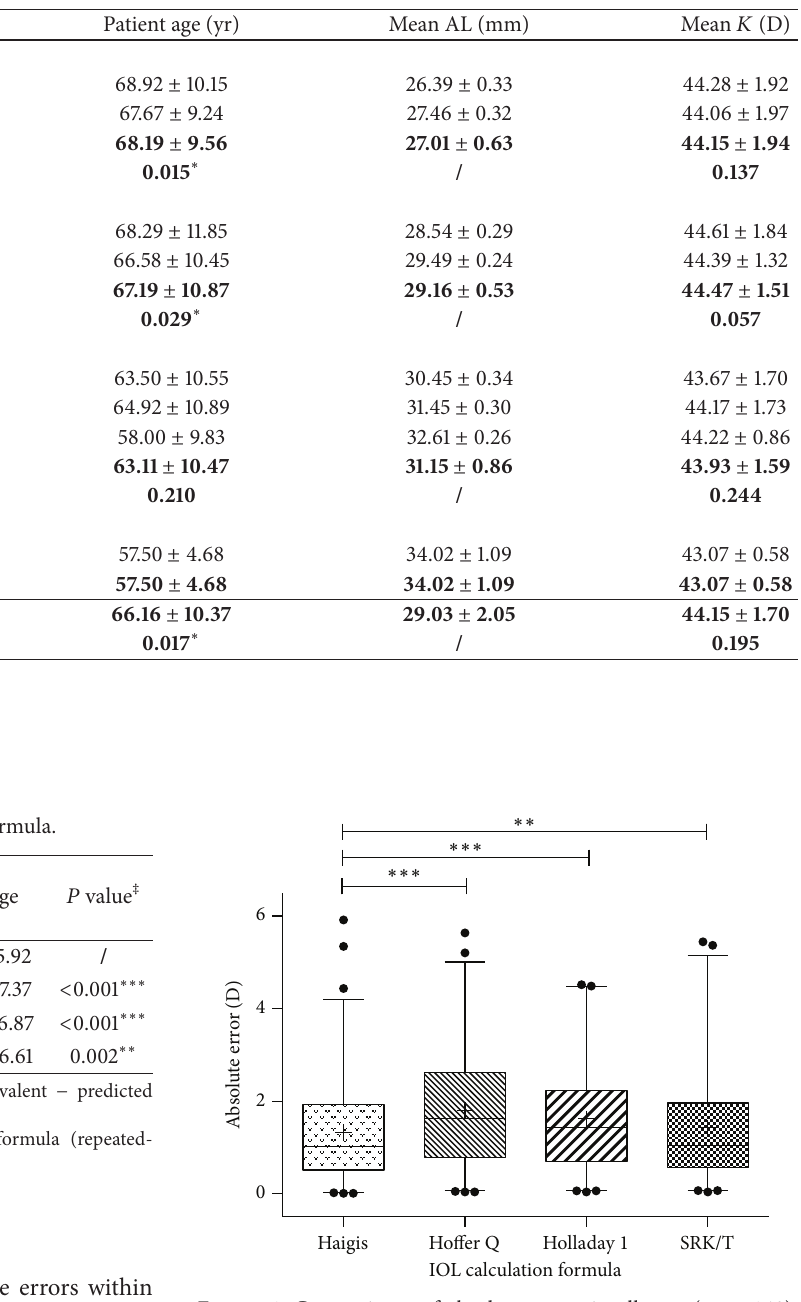
Figure 1: Comparisons of absolute errors in all eyes ( 𝑛 = 148 ). Absolute errors for the four intraocular lens (IOL) calculation formulas. The horizontal lines below and above the main box (whiskers) for each formula represent 2.5 and 97.5 percentile. The symbol + indicates mean absolute error, ∗∗ indicates 𝑃 < 0.01 , and ∗ ∗ ∗ indicates 𝑃 < 0.001 , as determined by a repeated-measures ANOVA test. D,